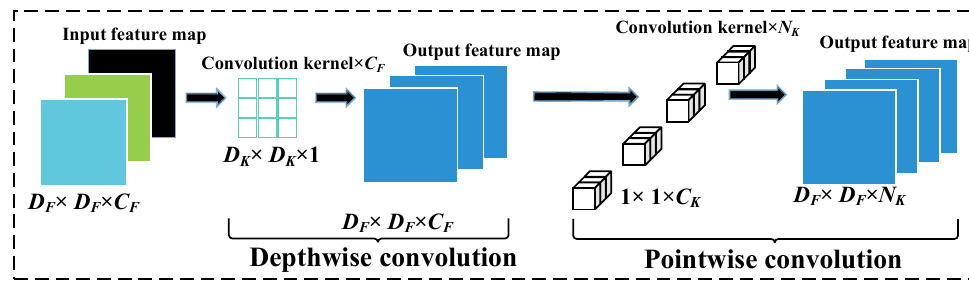
Figure 2. Depthwise separable convolution.